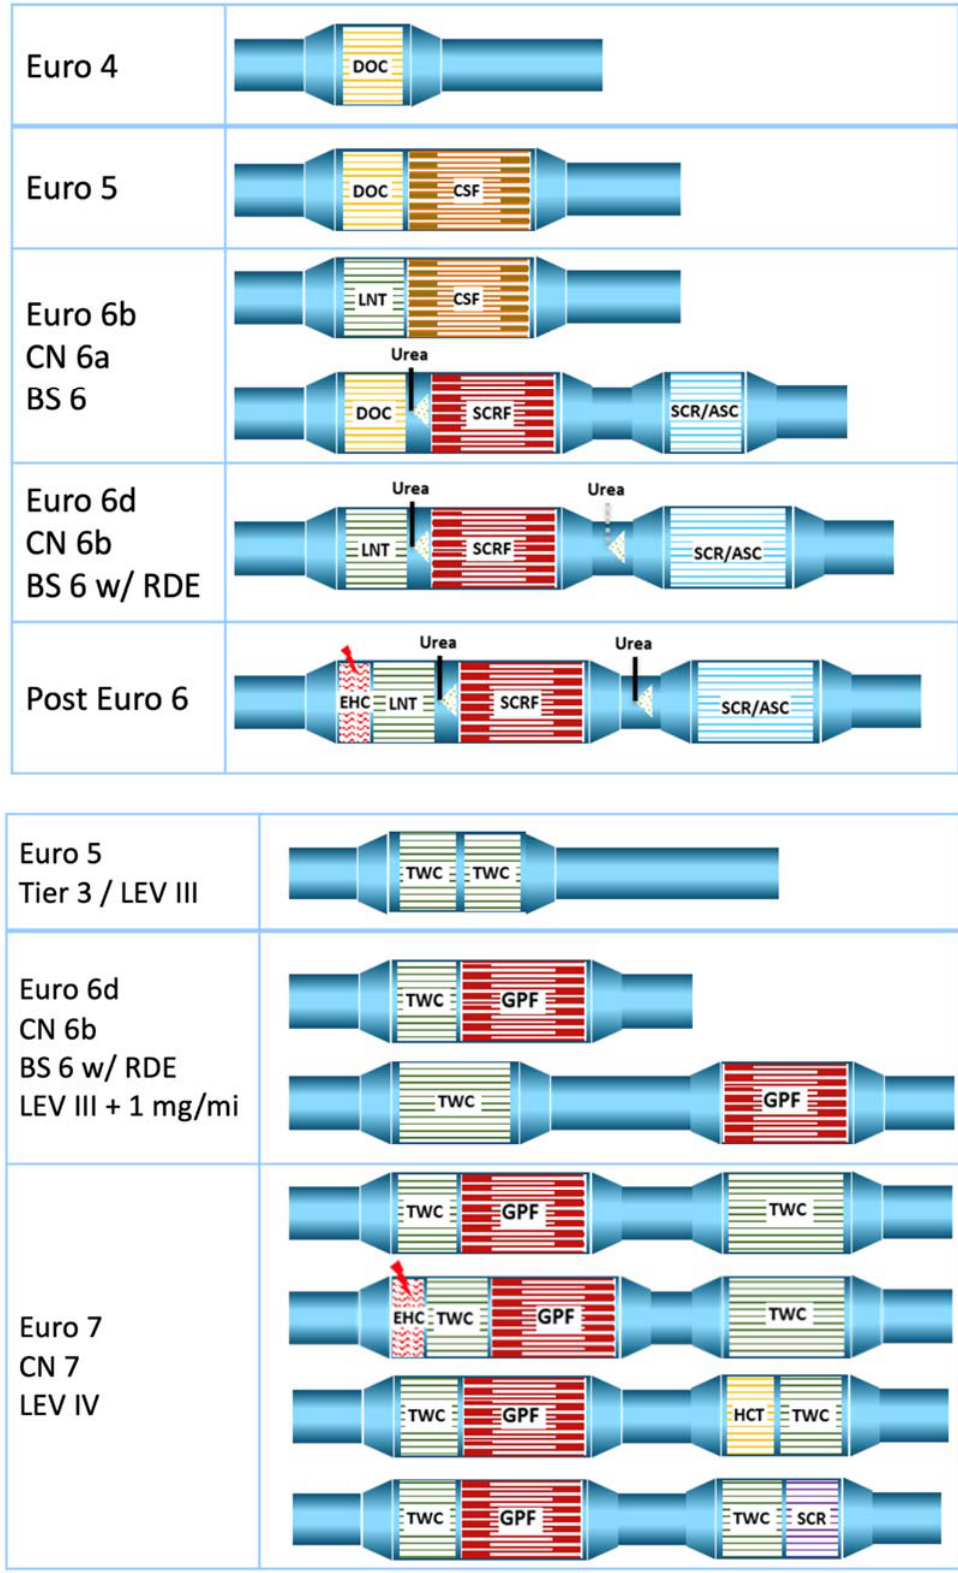
Figure 2. Evolution and newly proposed aftertreatment system (ATS) configurations for Diesel ( top panels ) and gasoline ( bottom panels ) LDVs.